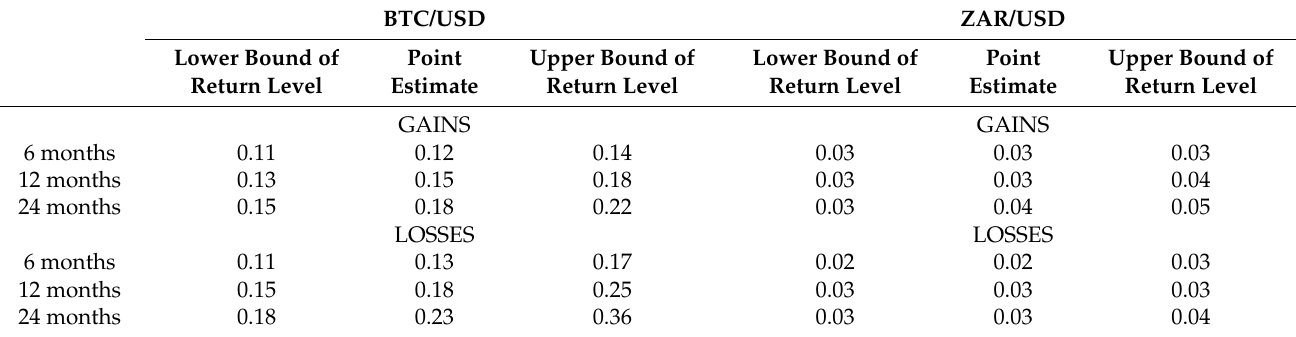
Table 3. Return levels estimates using the fitted GEVD